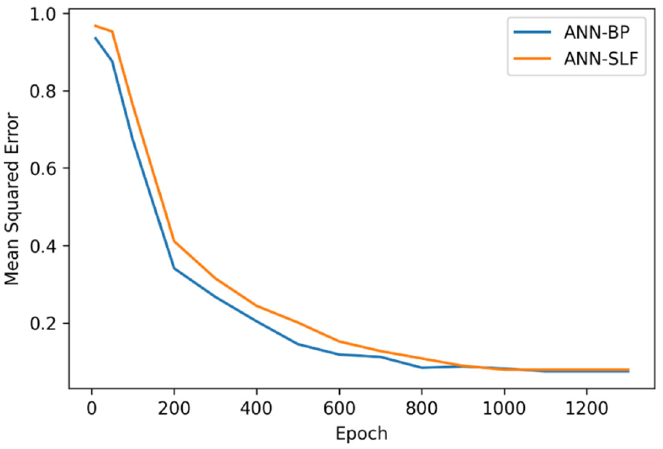
Figure 6. The mean squared error of ANN training using backpropagation and SLF.